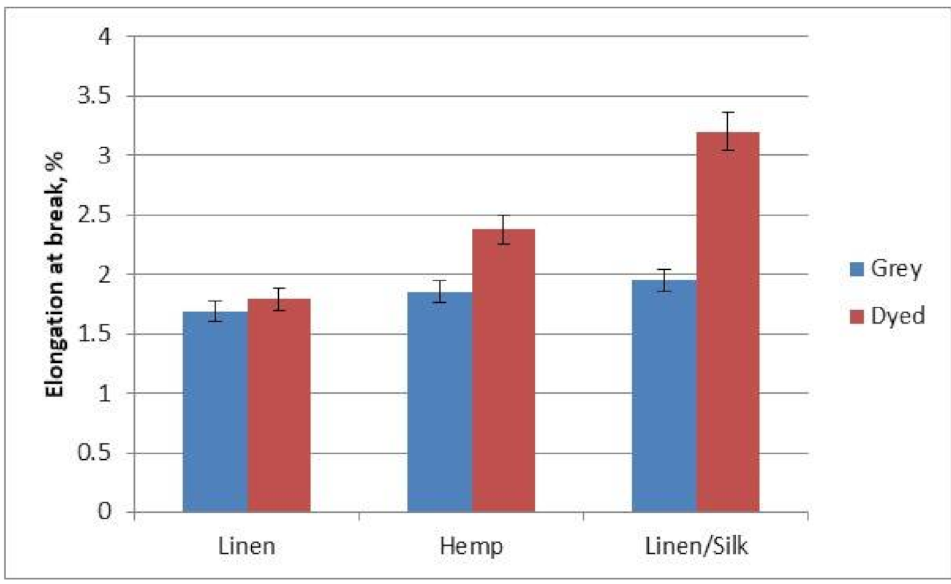
Figure 8. Diagram of the yarns’ elongation at